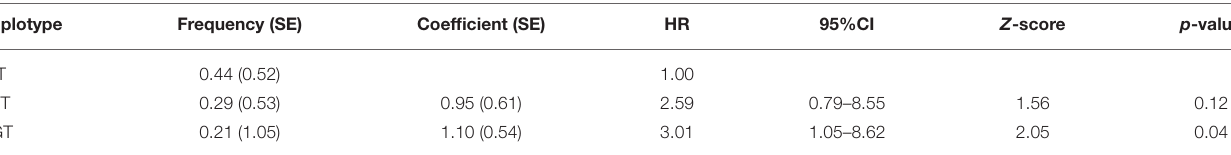
TABLE 5 | Estimated major SFTPD haplotypes and cox proportional hazard regression analysis for age at onset of PAC (adjusted for gender) using HPLus 2.5 software. Haplotype Frequency